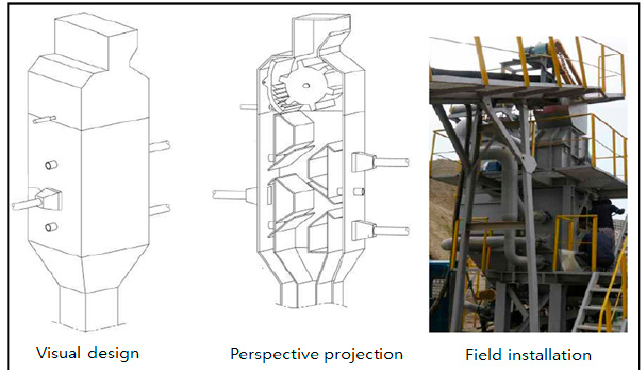
Figure 3. Appearance and perspective drawing of stripping the removal equipment for the impurities of recycled fine aggregate.